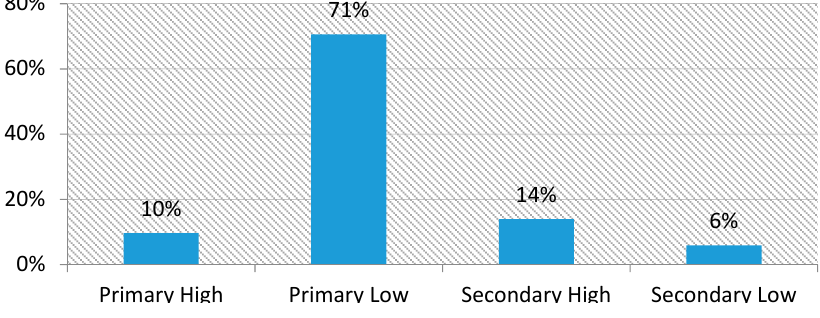
Figure 6. Percentages of Casualty level.